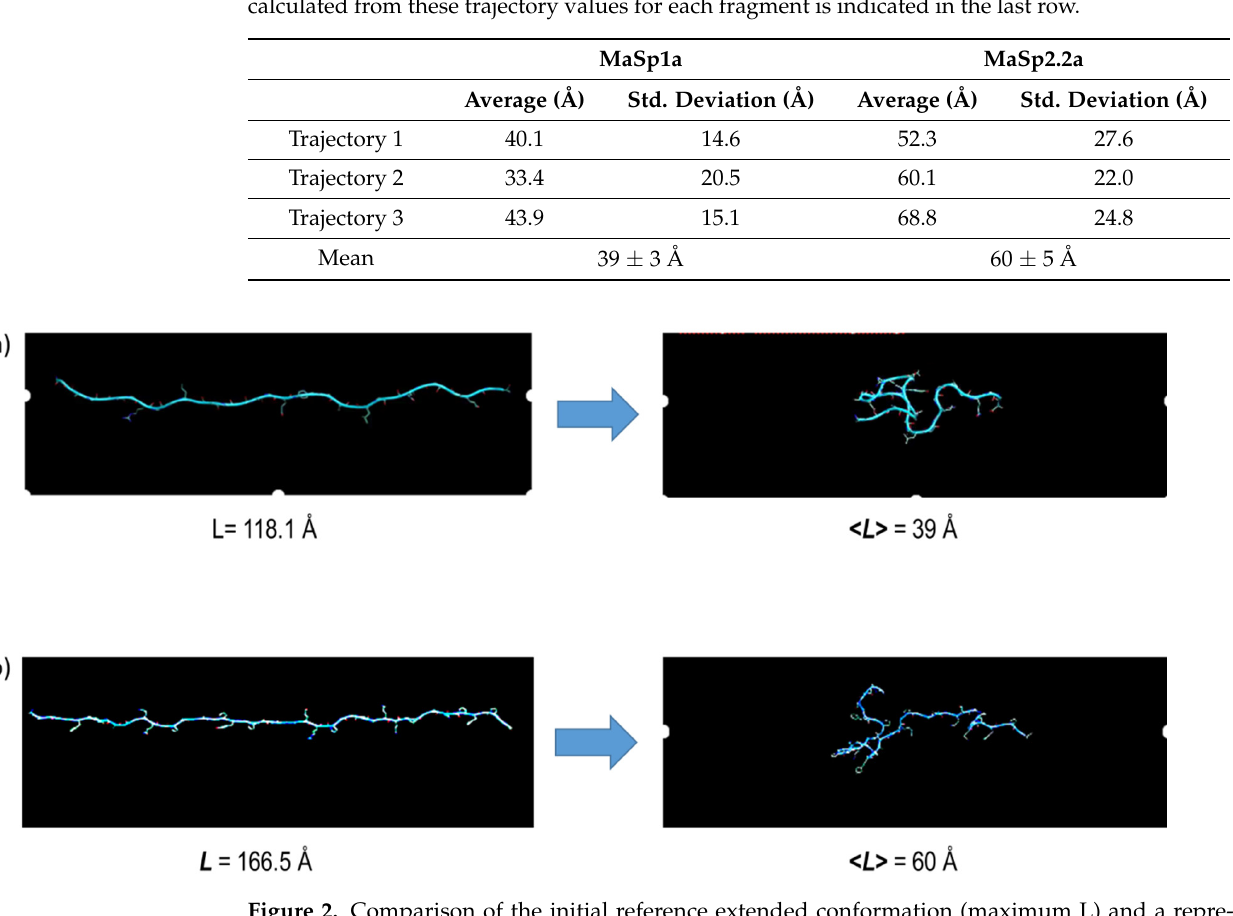
Figure 2. Comparison of the initial reference extended conformation (maximum L) and a representative conformation corresponding to the equilibrium state of the polyglycine-rich fragments of A. aurantia, ( a ) MaSp1a (spidroin 1) and ( b ) MaSp2.2a (spidroin 2), in MD simulations in the absence of external force. The distance between the end C α atoms of the alanine residues, L (Figure 1), is indicated. The value <L> corresponds to the arithmetic mean of the distance L obtained from three different independent trajectories calculated for each fragment in the absence of external force (Table 1).